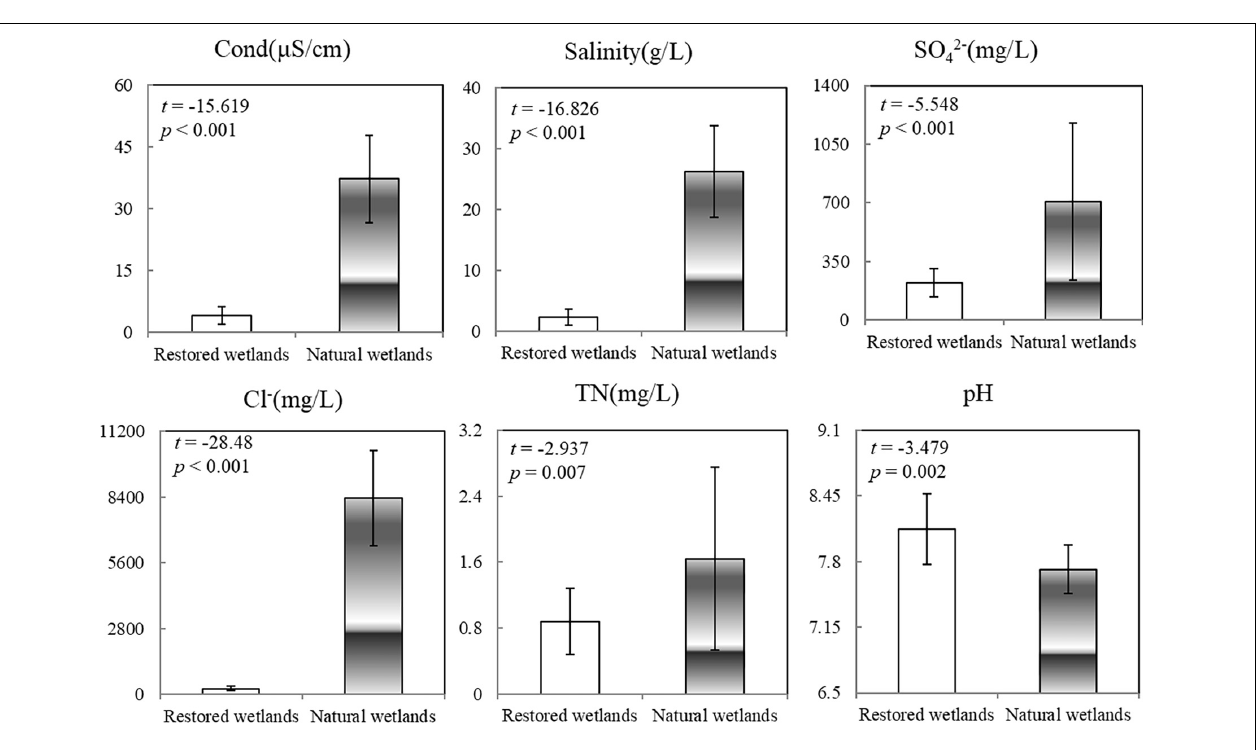
FIGURE 2 | Significant differences in water quality variables between restored and natural